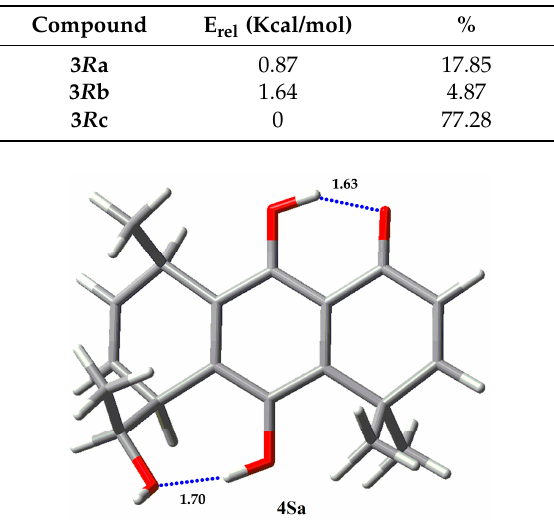
Table 4. Boltzmann population for rotamers of 3 R .